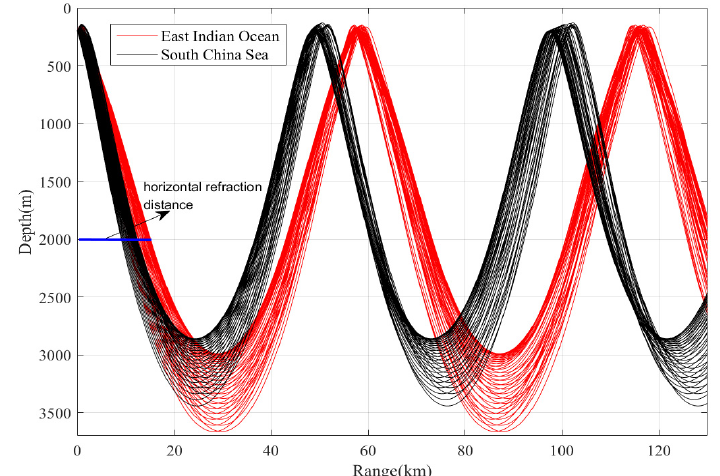
Figure 11. Sound rays for the environments of the EIO (red line) and SCS (black line).